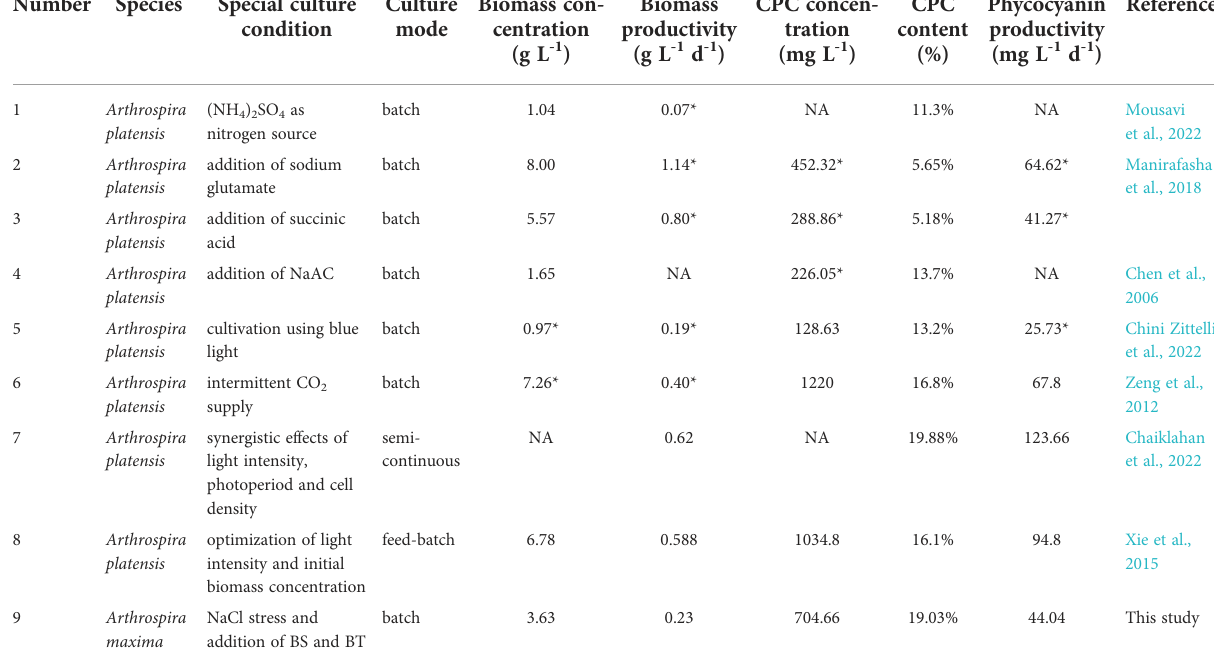
TABLE 5 Summary of algal growth and phycocyanin production of Arthrospira reported in the literature and this